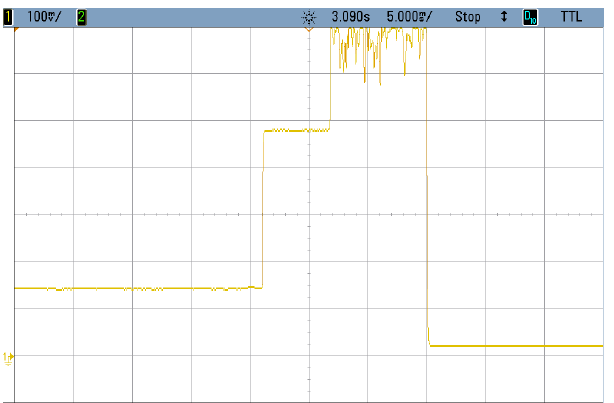
Figure 17. Detail (MD5, HW, 2000, COMP, -).